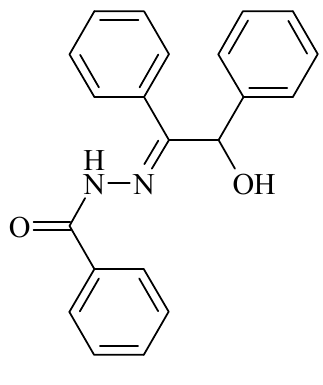
Figure 1. The structure of ionophore